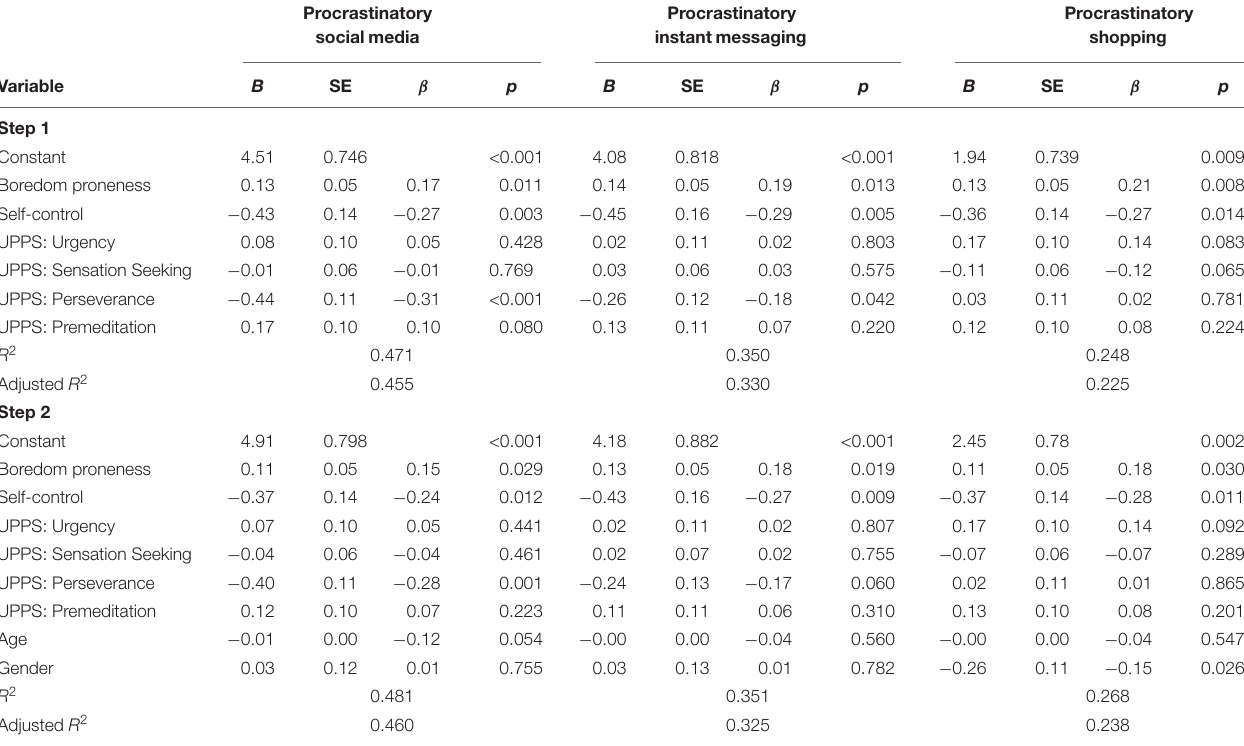
TABLE 6 | Hierarchical regressions predicting online procrastination in the Turkish